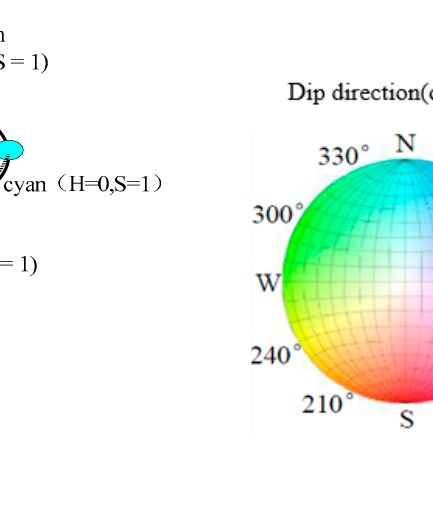
Figure 12. HSV color space and HSV color